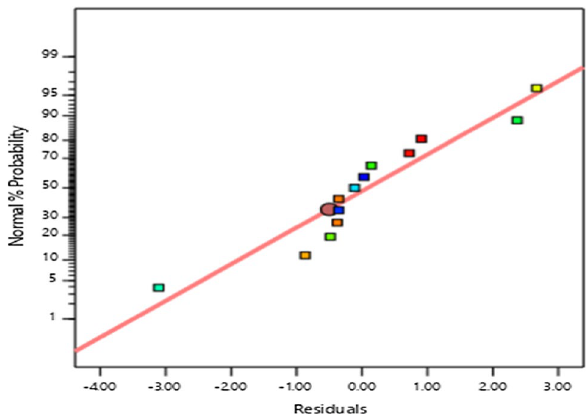
Fig. 2 Normality % probability vs. residual plot for percent